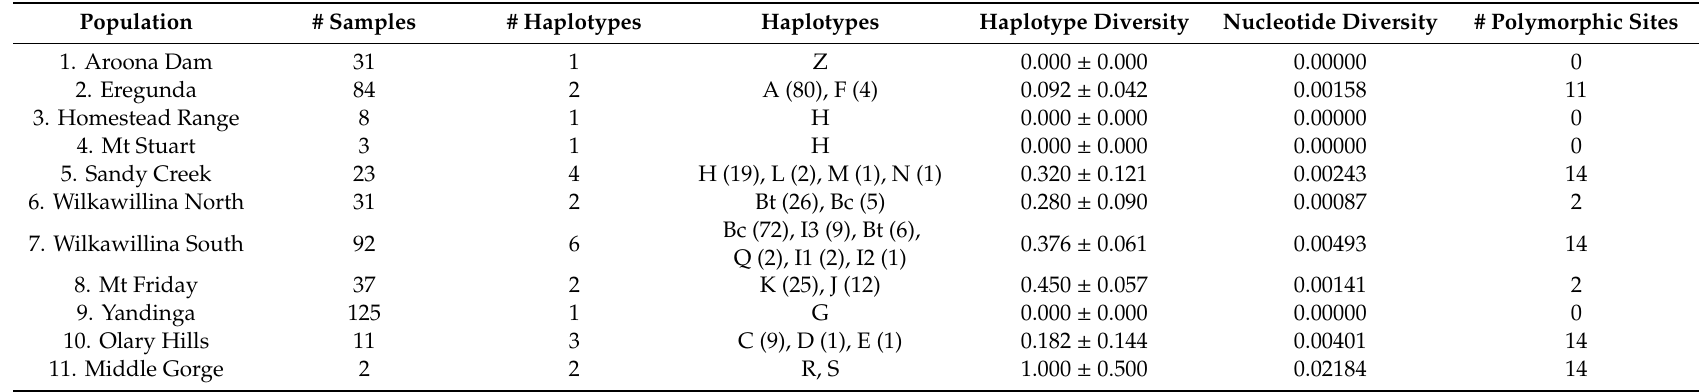
Table 1. Genetic diversity indices for mitochondrial control region sequences for 11 populations of P. x. xanthopus , including: number of samples sequenced (# samples), number of haplotypes in each population (# haplotypes), and the haplotype identifiers (haplotypes), haplotype diversity, nucleotide diversity, and the number of polymorphic sites in a population (# polymorphic sites). Average ± standard deviation.